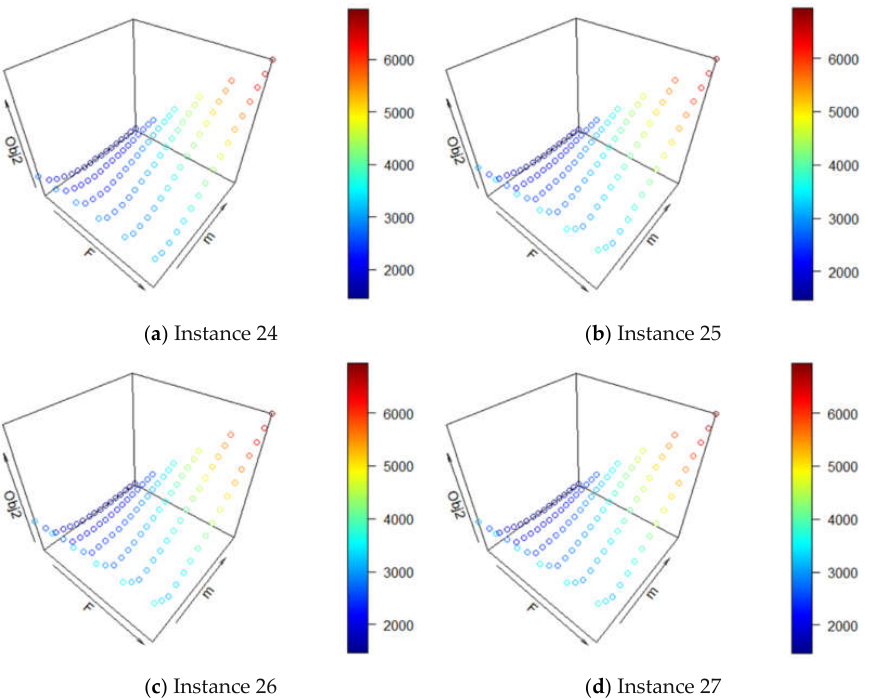
Figure 9. Cross-validation of m and F on the total cost while c = 0.10. ( a ) Instance 24; ( b ) Instance 25; ( c ) Instance 26; ( d ) Instance